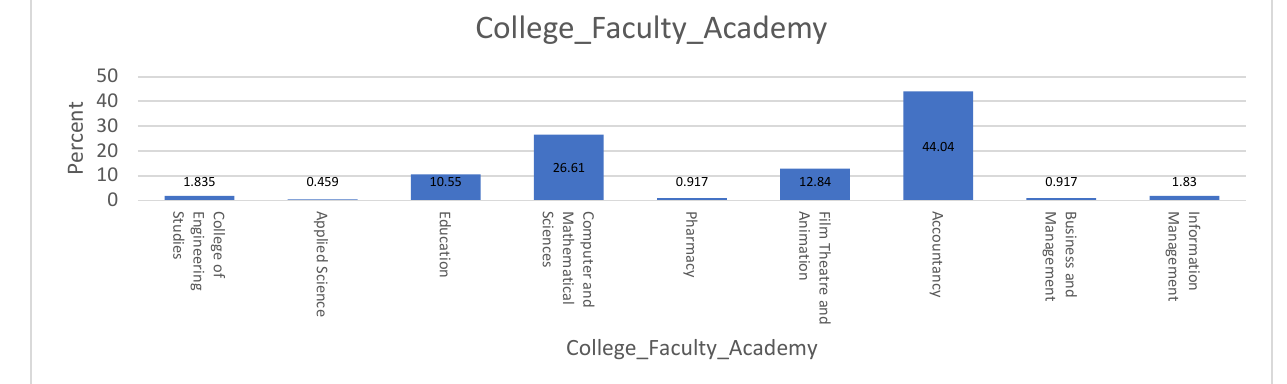
Figure 1. Distribution of respondents according to college and faculties. Table 6. Item-total statistics: item and values in five components of perceptions on digital skills.